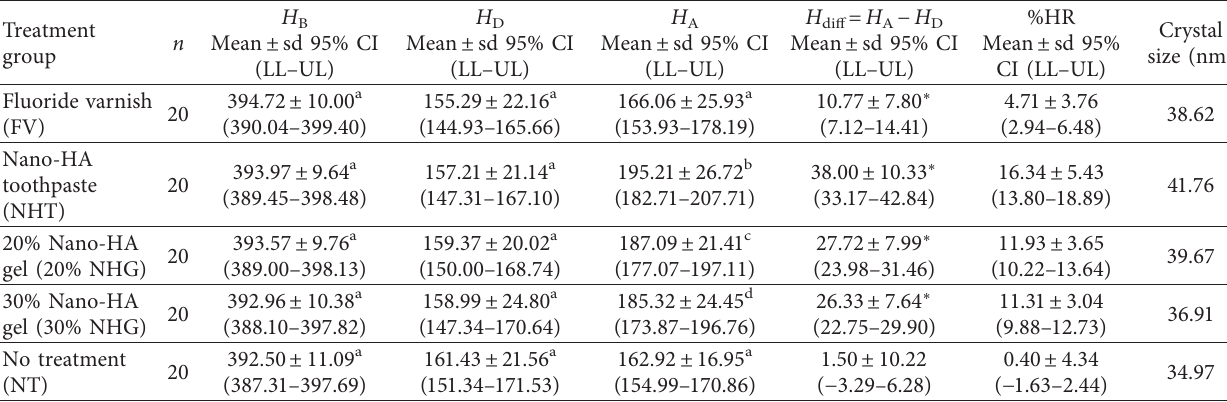
Table 2: Mean ± standard deviation (sd), 95% confidence interval (CI) of hardness at baseline ( H mineralization ( H D ), hardness after application of remineralizing agent ( H A ), hardness difference determined between after acid-activated demineralization and after application of remineralizing agents ( H AD-diff � H A − H D ), percentage of hardness recovery (%HR) of each group after application of remineralizing agents ( H A ) in comparison to after acid-activated demineralization ( H D ), and average crystal size for each treatment group.